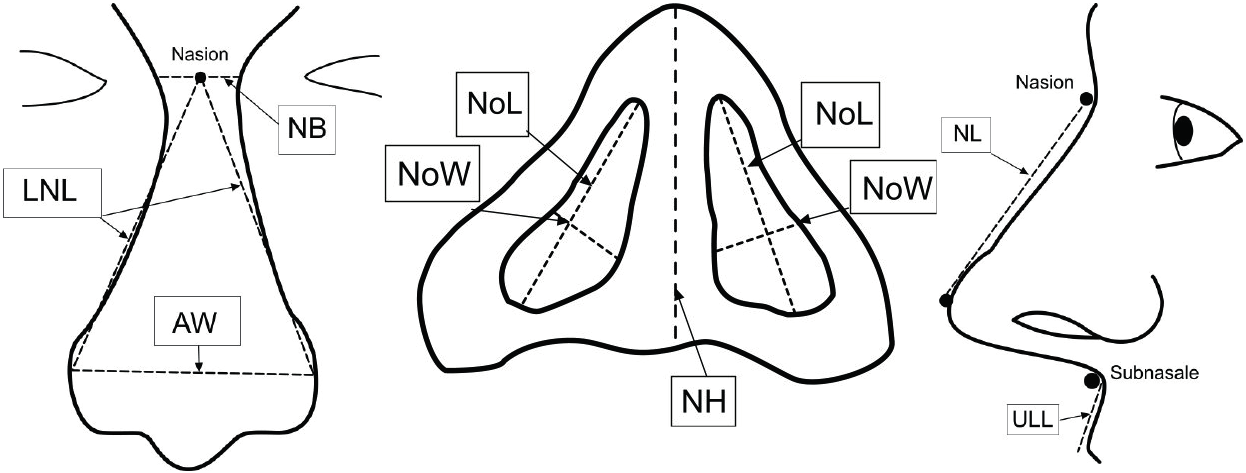
Figure 1. Growth-dependent anthropometric parameters in males and females. NB, nasal base; AW, alar width; LNL, lateral nasal length; ULL, upper lip length; NoW, nostril width; NH, nasal height; NoL, nostril length; NL, nasal